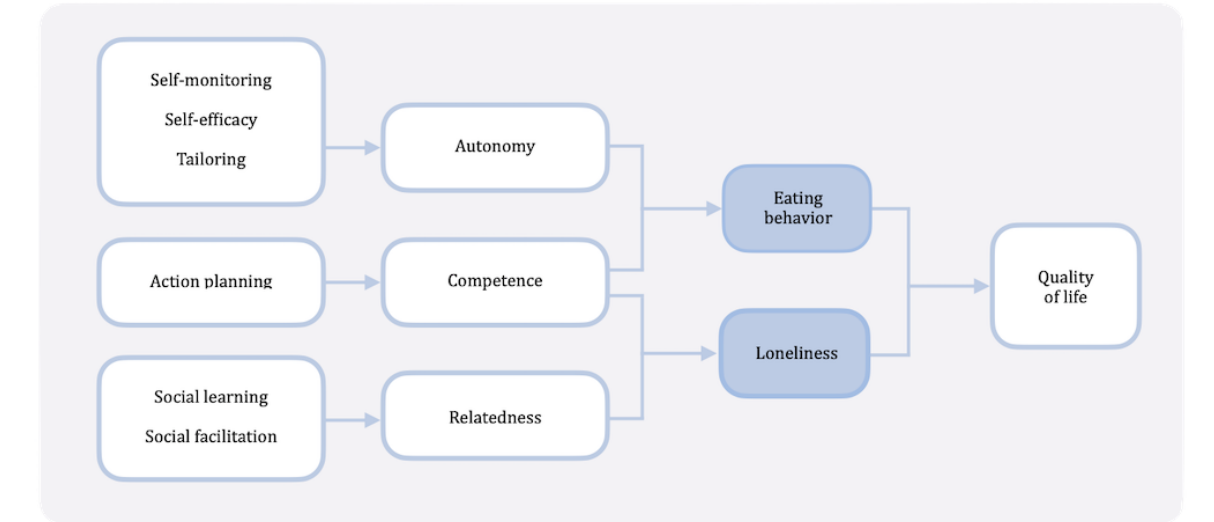
Figure 2. Conceptual model explaining health effects, known as